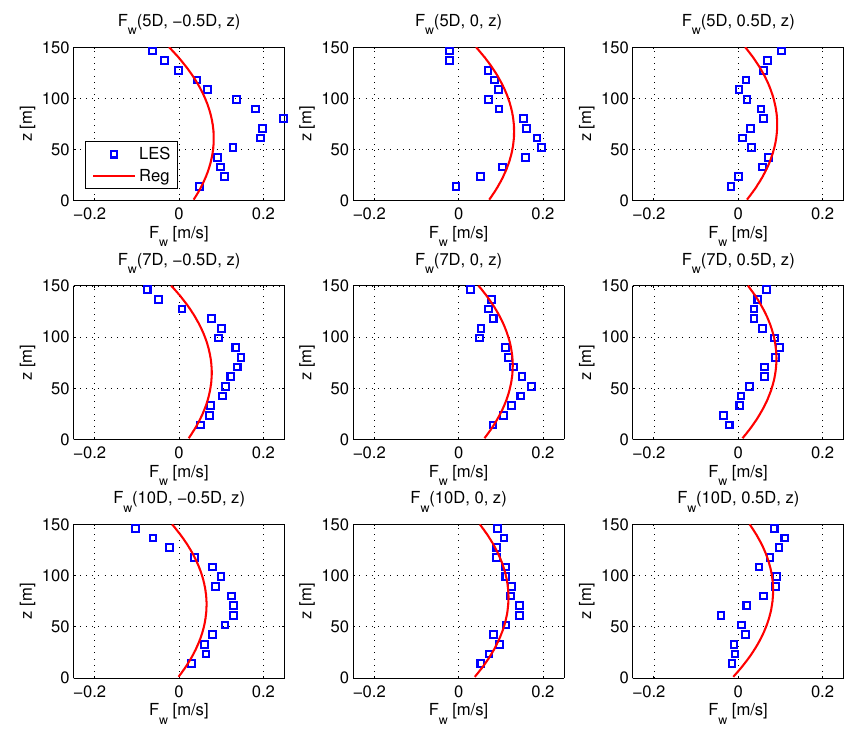
Figure 20. Spatial variation of F w : LES versus regression-based